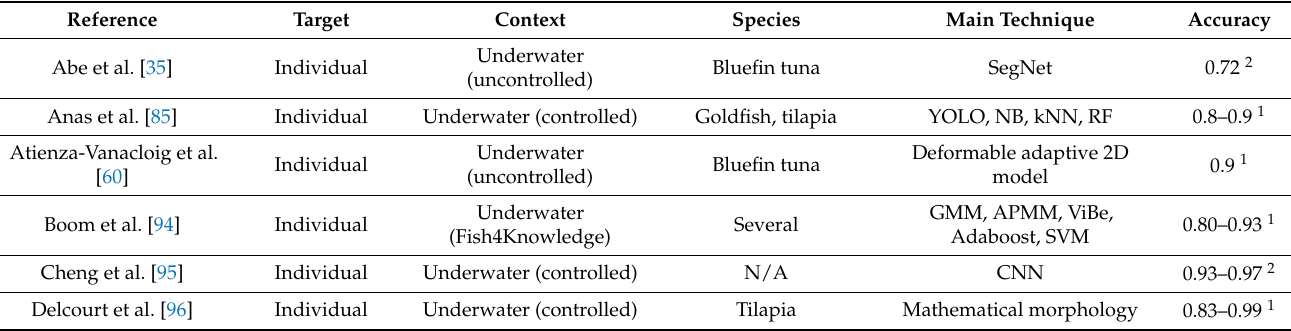
Table 5. List of articles dealing with tracking